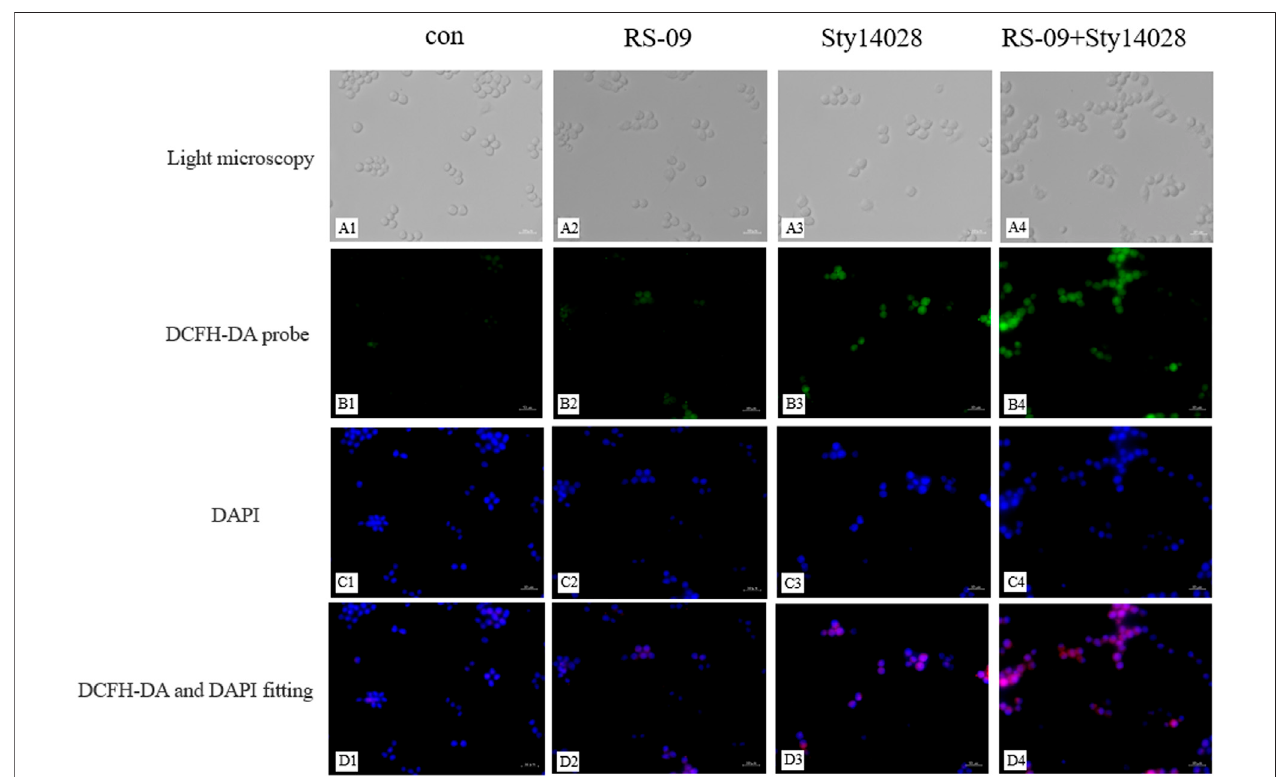
FIGURE 7 | Effect of RS-09 on Sty14028-induced ROS generation in RAW264.7 macrophages. RAW264.7 cells were cultured in DMEM for 12 h and then incubated with the probe DCFH-DA (green) for 30 min. DNA was stained with DAPI (blue) for 10 min (A1 – A4) The cell morphology was observed by light microscopy. (B1 – B4) ROS detection was performed using fl uorescence macroscopy (C1 – C4) Treated cells were stained with DAPI and observed under fl uorescence microscopy (D1 – D4) Merged image of DCFH-DA and DAPI. These experiments were repeated independently 3 times